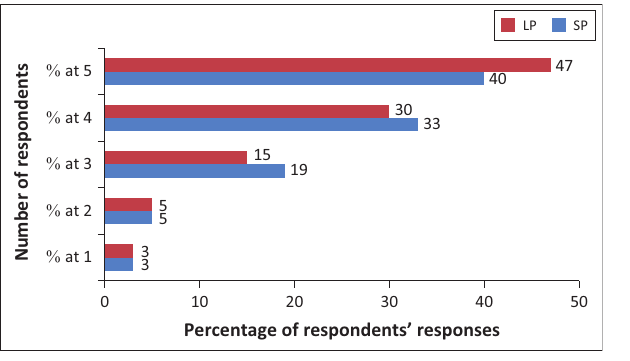
FIGURE 5: Confirmatory factor analysis on entrepreneurial intention.